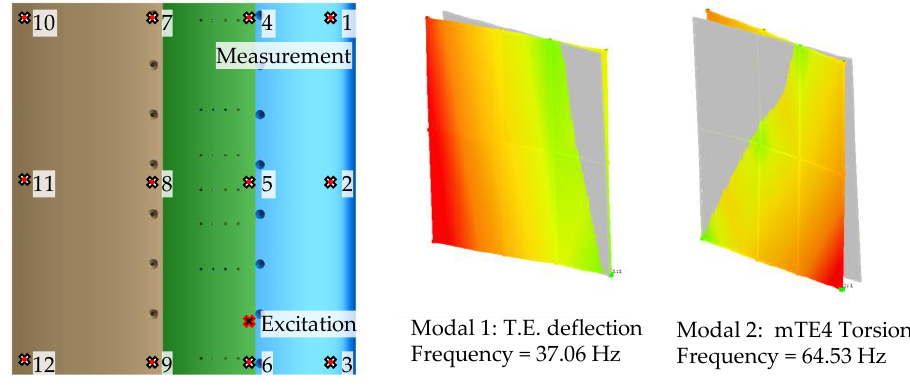
Figure 10. The first two modes of mTE4.